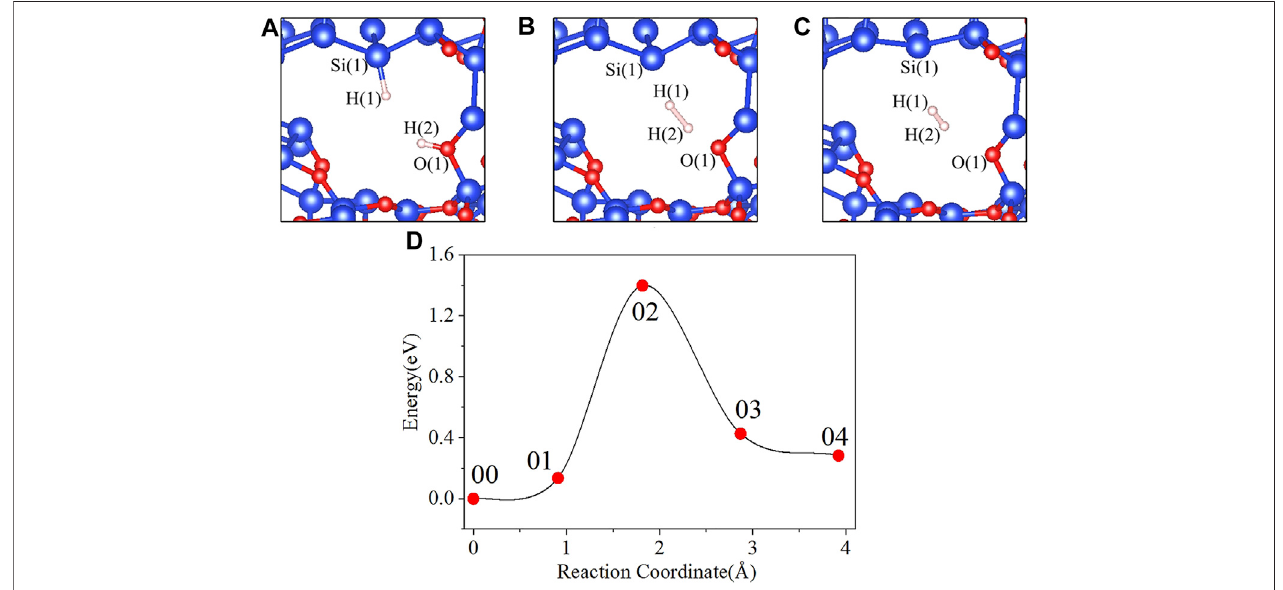
FIGURE2| Intermediatestatesandenergypro fi lecurveofthe P b defectdepassivationreaction. (A) 01state, (B) 02state, (C) 03state,and (D) energypro fi lecurve.